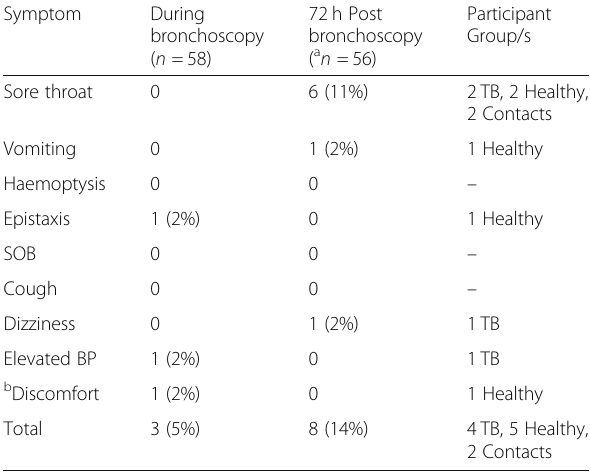
Table 3 Complications during bronchoscopy and post bronchoscopy symptoms at 72 h